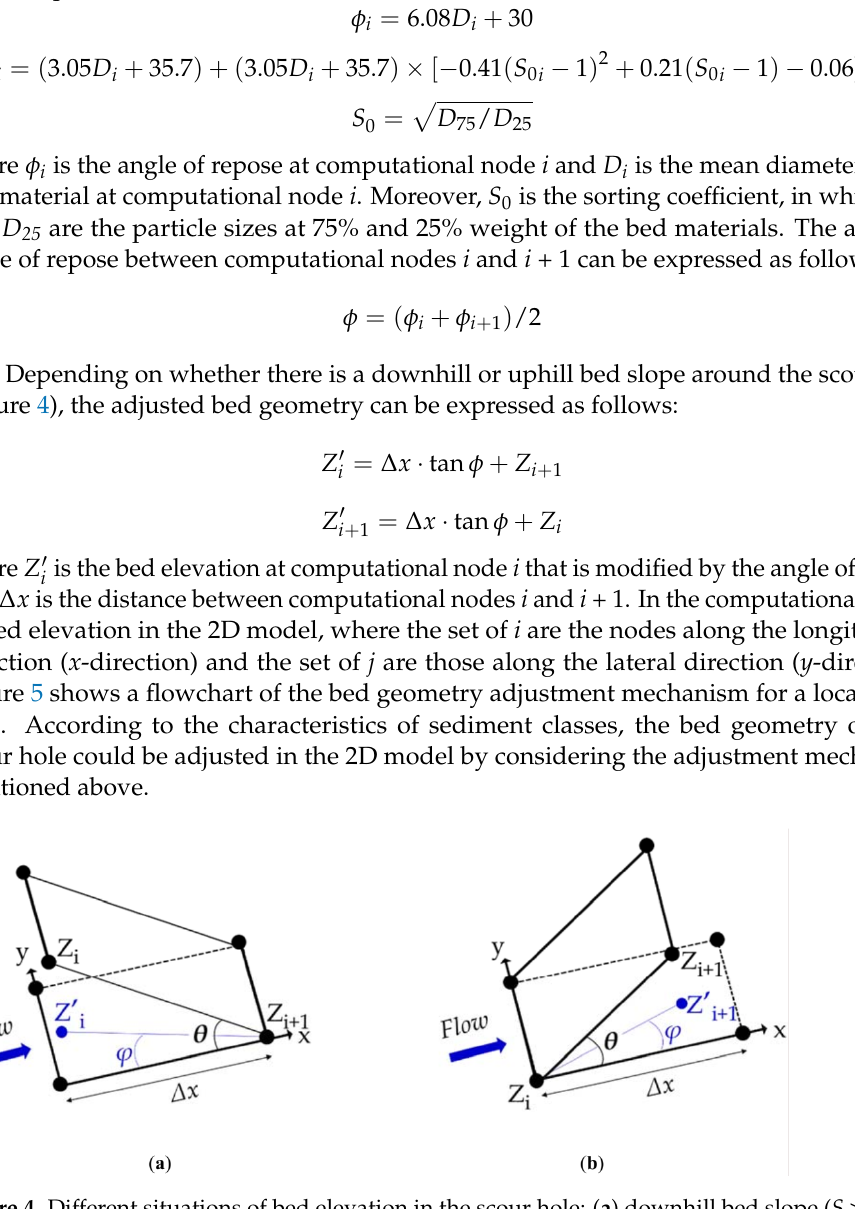
Figure 4. Different situations of bed elevation in the scour hole: ( a ) downhill bed slope ( S > 0) and ( b ) uphill bed slope ( S <